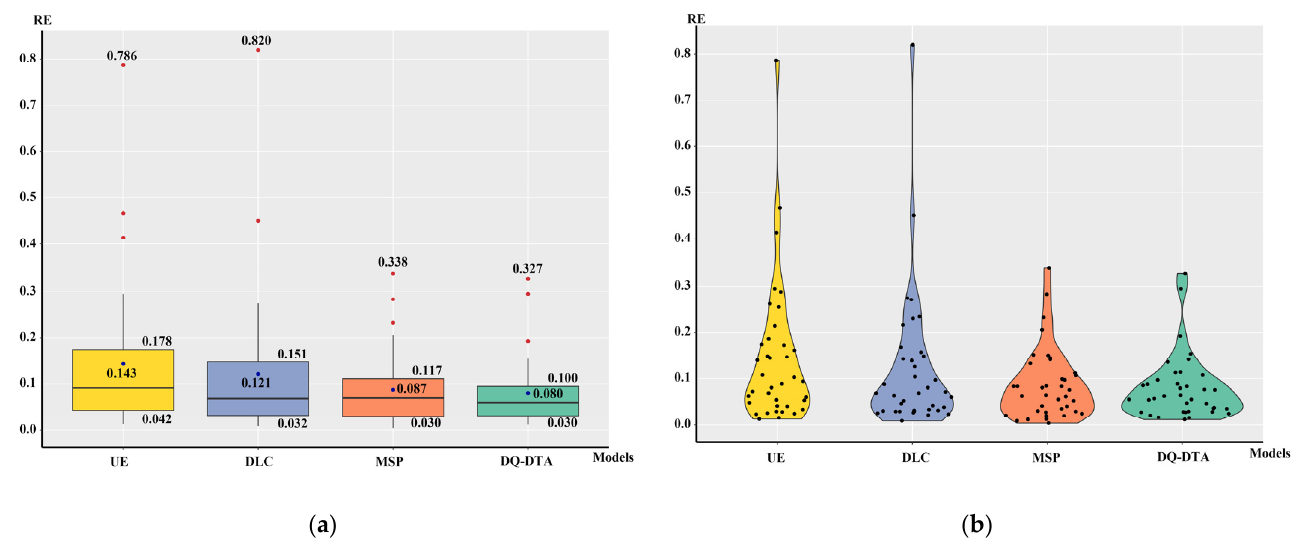
Figure 7. The mean relative error of observed links by the UE, DLC, MSP, and DQ-DTA models.